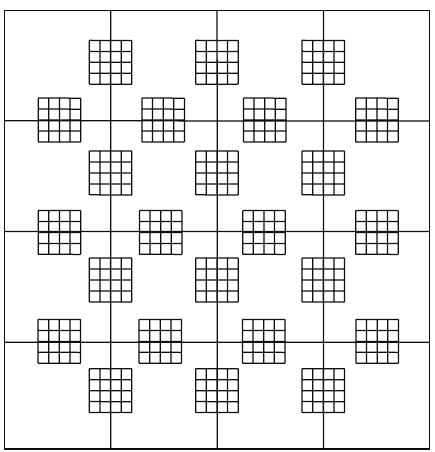
Figure 1: Illustration of the macroscopic and microscopic compu- tational